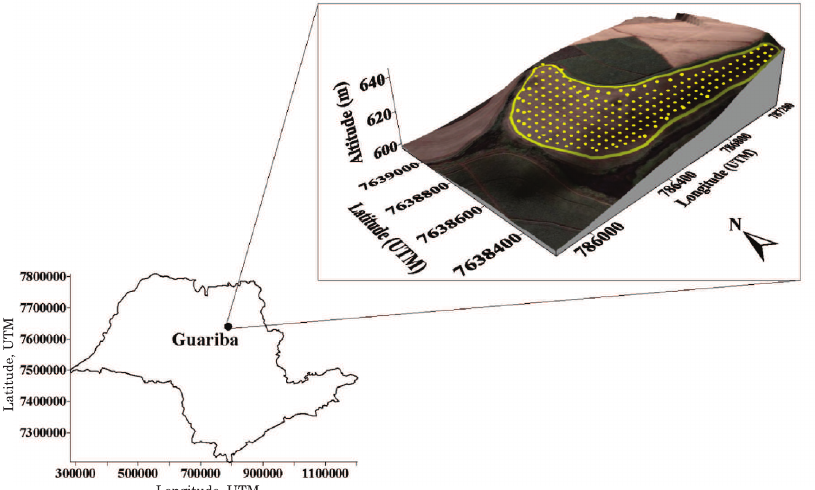
Figure 1. Studied area location and soil sampling grid